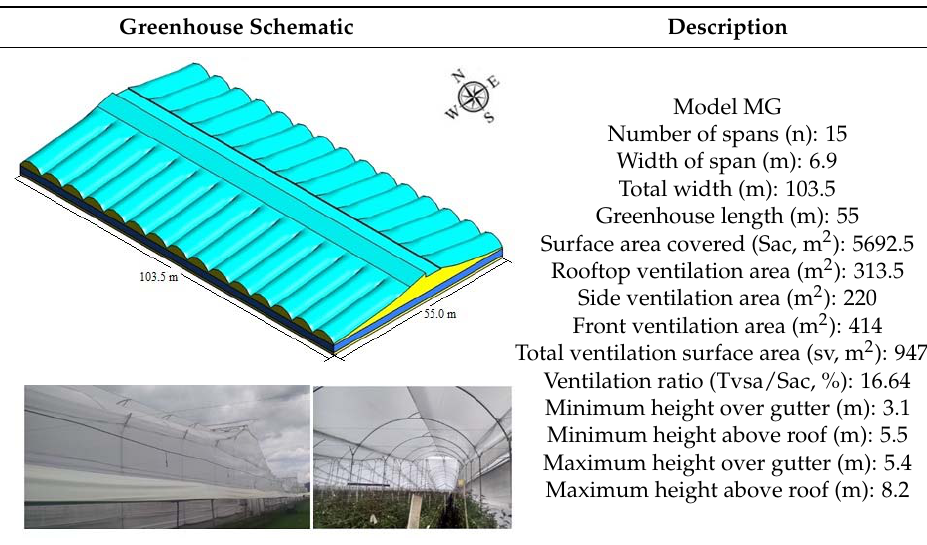
Table 2. General characteristics of the MG greenhouse.